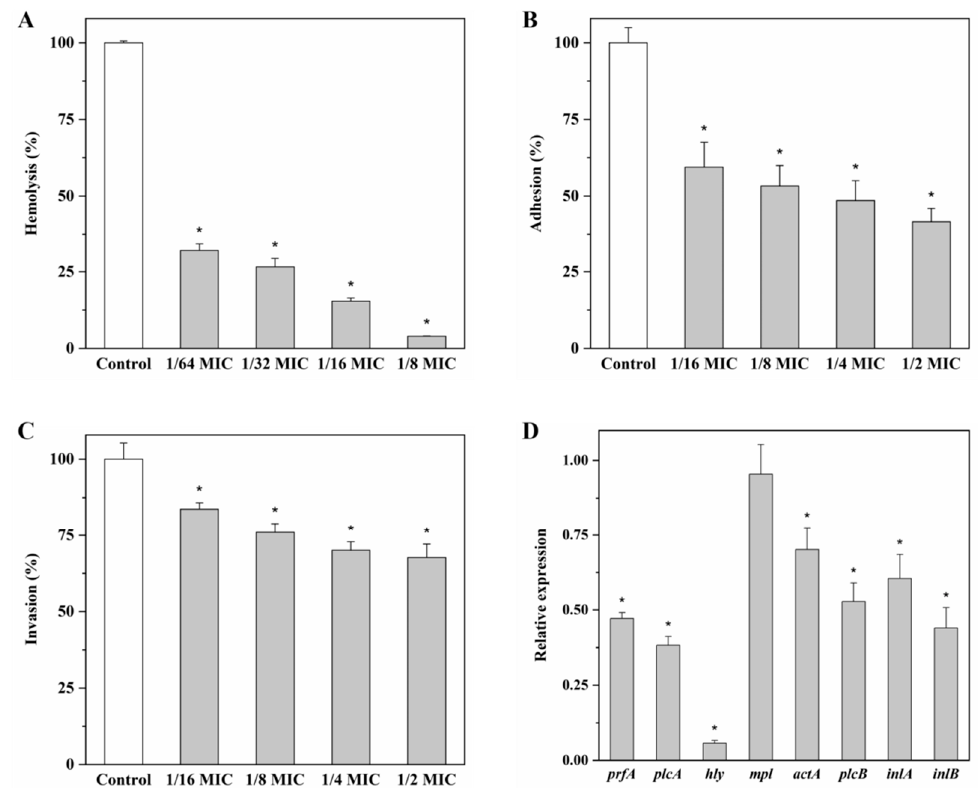
FIGURE 5 Figure 5. Effect of andrographolide on ( A ) the hemolytic activity, ( B ) the capacity to attach Caco-2 cells, ( C ) the capacity to invade Caco-2 cells, and ( D ) the expression levels of virulence genes, and the results from qRT-PCR are presented as fold changes relative to the expression level of the target gene in L. monocytogenes 10403S in BHI. Error bars represent the standard deviation of triplicate experiments ( n = 3). The asterisk indicates a value statistically different from that of the control, with p <